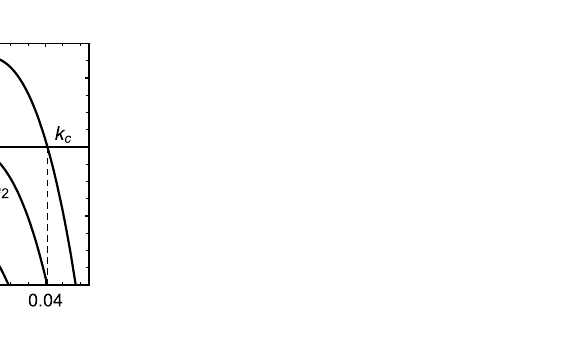
3 / 4 . In this case, le 2 =